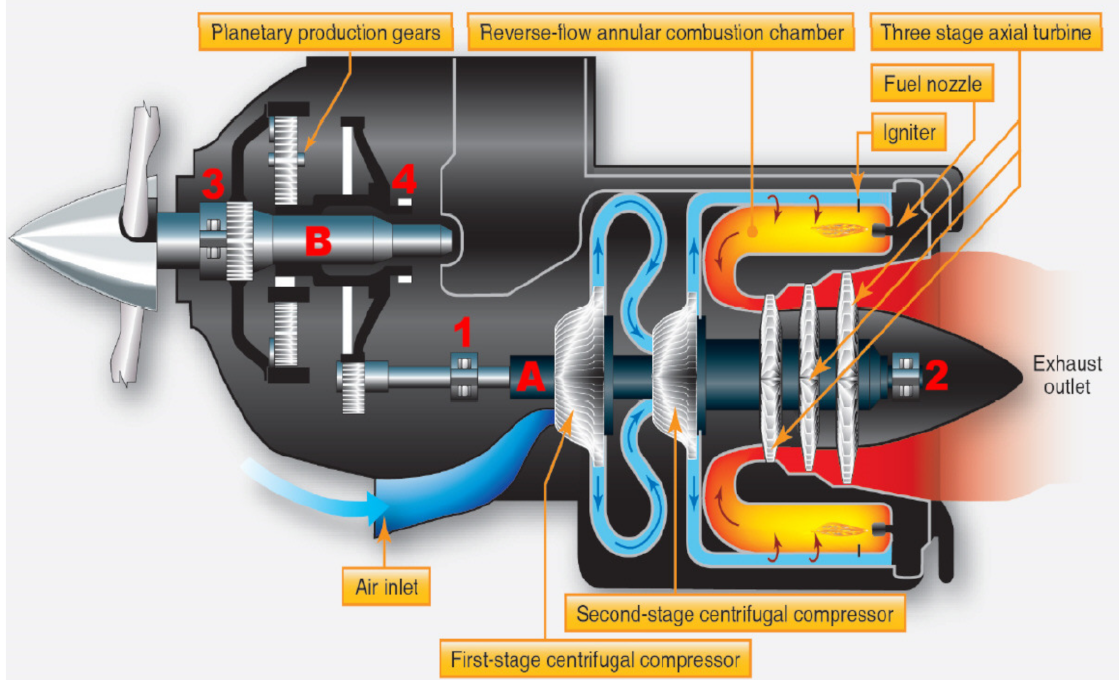
Figure 1. Garrett TPE331 turboprop engine (based on [18], p. 15-3). A. main shaft (engine shaft) with the gas turbine. B. propeller shaft with the reduction gear. 1,2. bearings that support the main shaft. 3,4. bearings that support the propeller shaft. 1. compressor